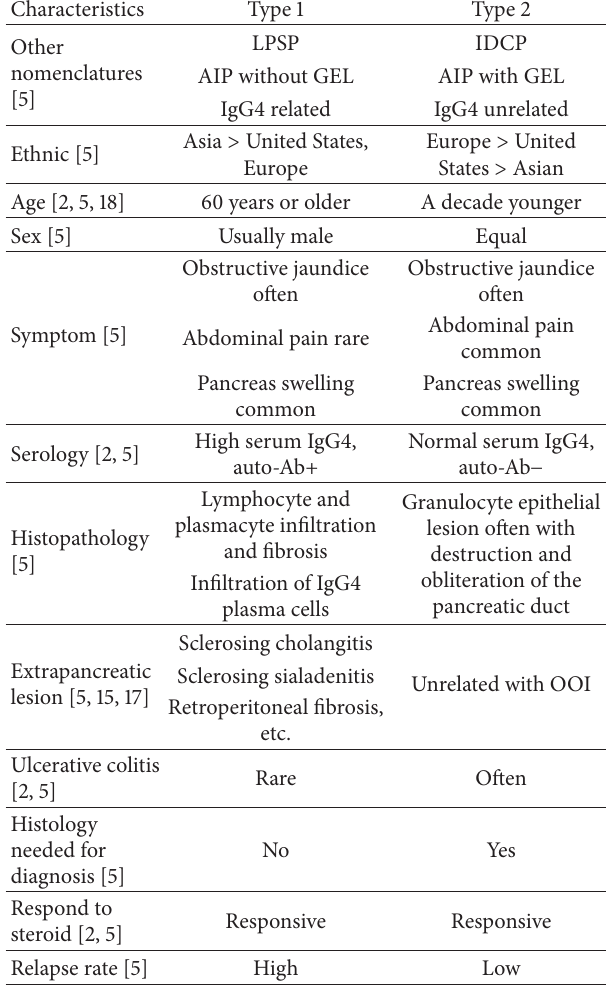
Table 1: Comparisons of the two types of